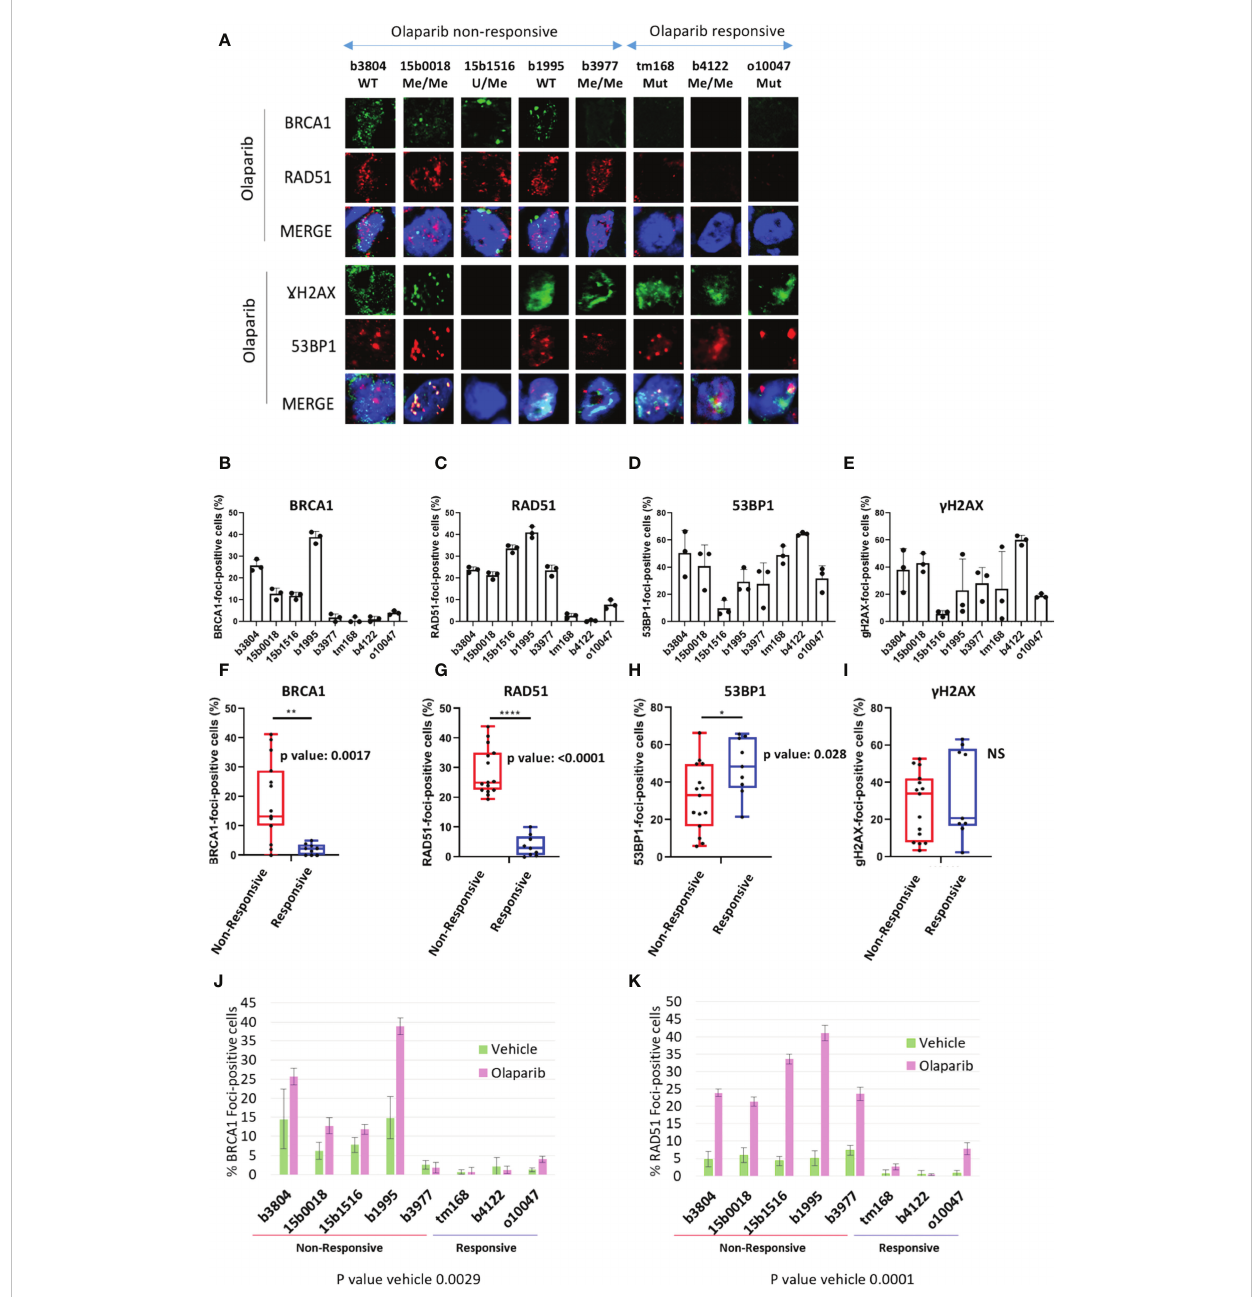
FIGURE 3 BRCA1, RAD51, g H2AX and 53BP1 nuclear foci formation in olaparib treated PDX. (A) Representative immuno fl uorescence images of frozen PDX tissue section harvested from mice sacri fi ced after the last administration of olaparib or before the tumor reached ethical size for vehicle treated models. PDX tumor sections were ordered from worst to best olaparib response. A complete version including vehicle treated tumors is visible in Supplementary Figure 5. (B) Quanti fi cation of BRCA1, (C) RAD51, (D) g H2AX, (E) : 53BP1 foci formation in olaparib treated